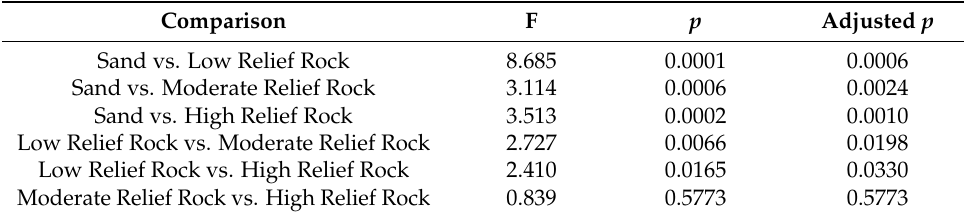
Table 6. Results of the pairwise PERMANOVA tests with 9999 iterations to assess differences in fish communities between each pair of habitat types. The F statistic, a p value, and an adjusted p value using a sequential Bonferroni procedure to account for multiple comparisons are